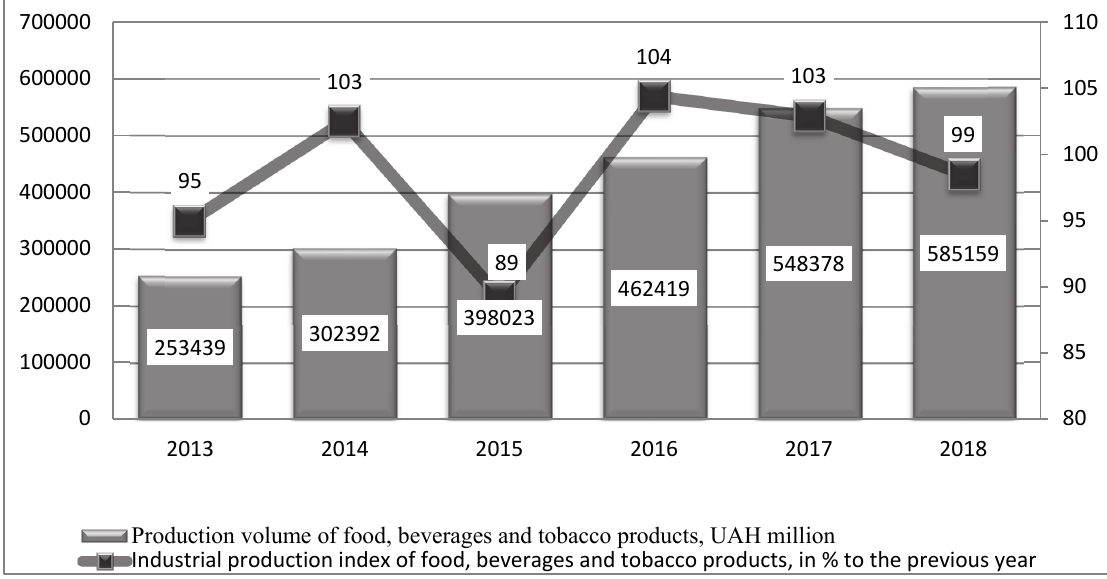
Fig. 1 . Dynamics of production and indices of food, beverages and tobacco products in